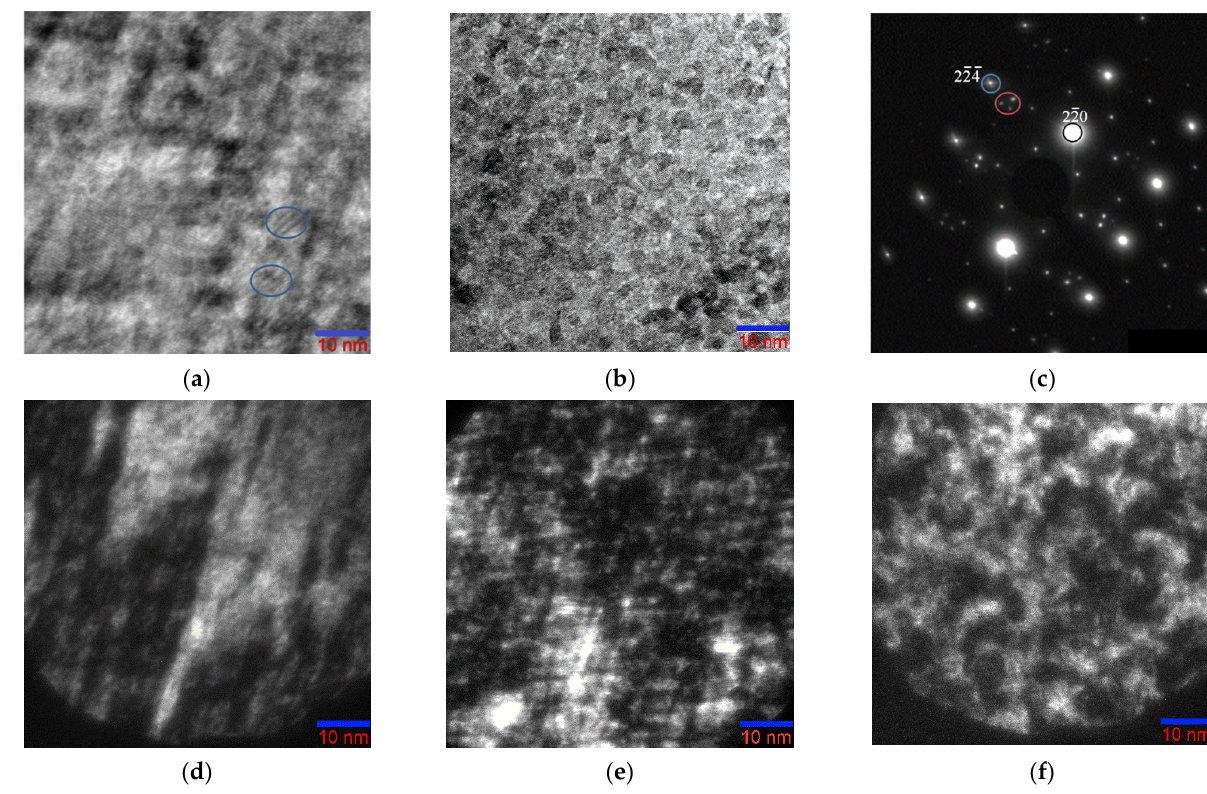
Figure 6. Structures of the Ni 46 Mn 41 In 13 alloy in the austenitic state at room temperature: ( a , b ) bright- field TEM images; ( c ) microelectron diffraction pattern obtained from area ( a ); ( d – f ) dark-field images in reflections (224) L21 , (220) L21 , and triple reflex, respectively. Zone axis [110] L21 .